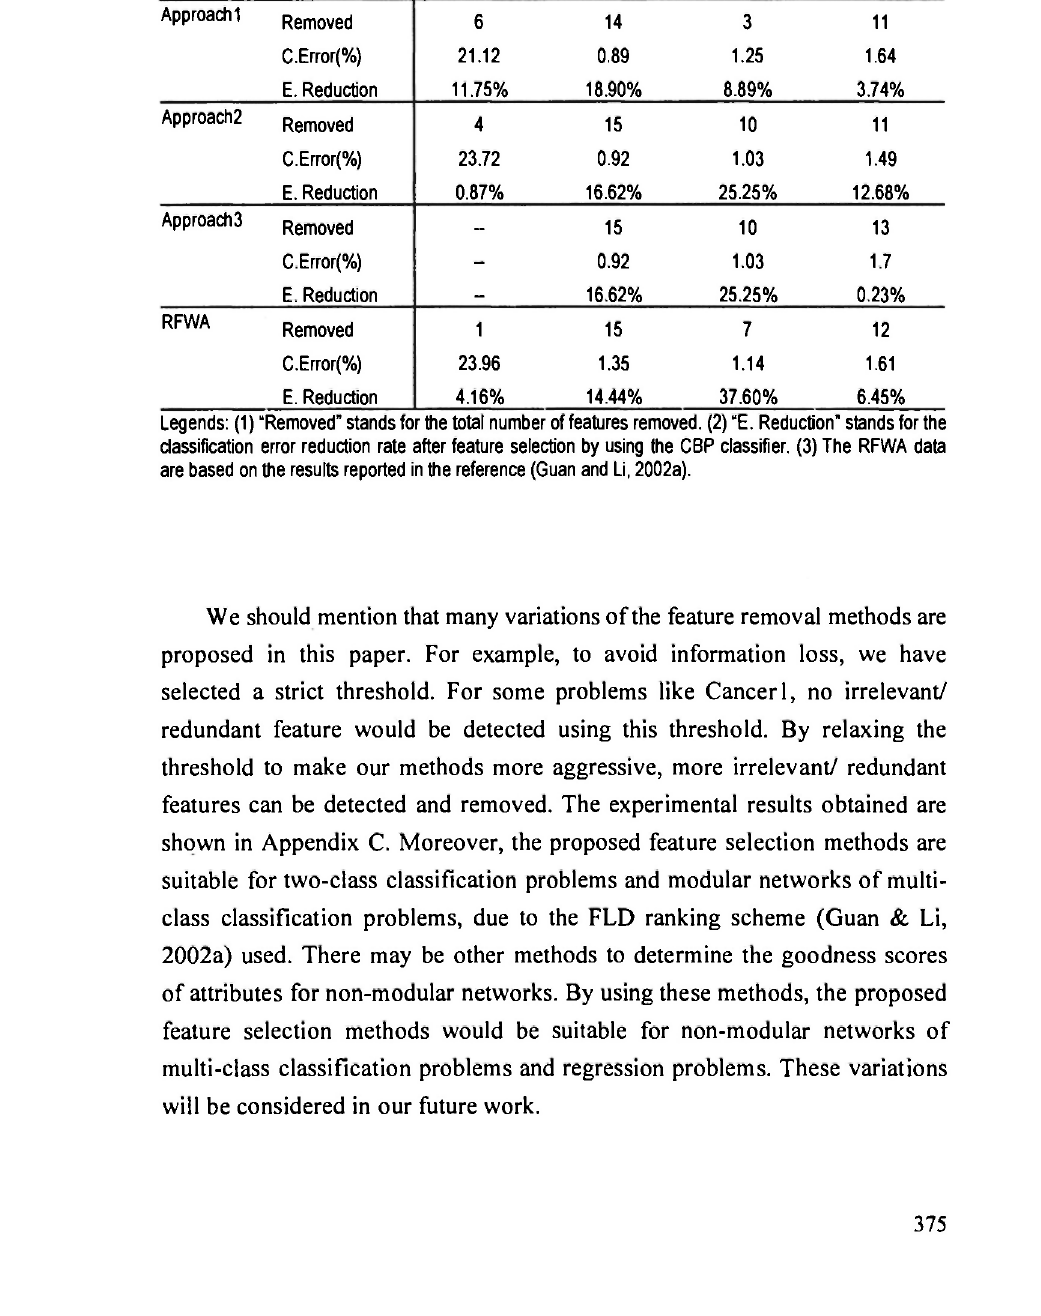
Comparison of the results obtained by ITID and RFWA (Guan and Li, 2002a)